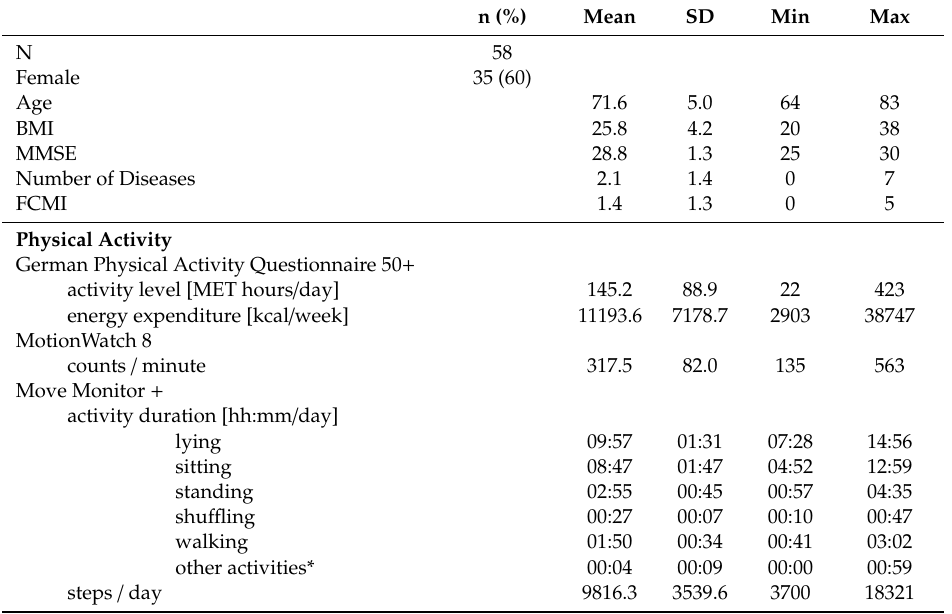
Table 1. Sample characteristics and physical activity results of the German Physical Activity Questionnaire 50 + , MotionWatch8, and the Move Monitor +